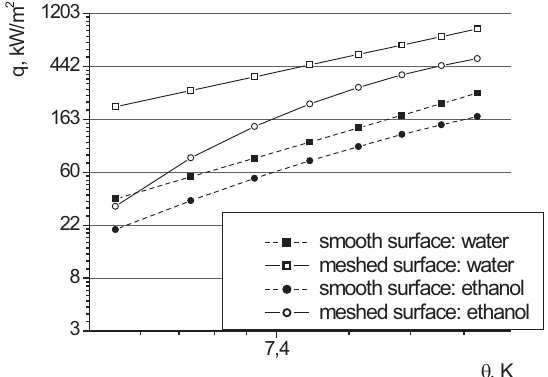
Fig. 4. Boiling curves for smooth and meshed surfaces. Data for the smooth surface as in Ł. J. Orman and T. Orzechowski (2009)